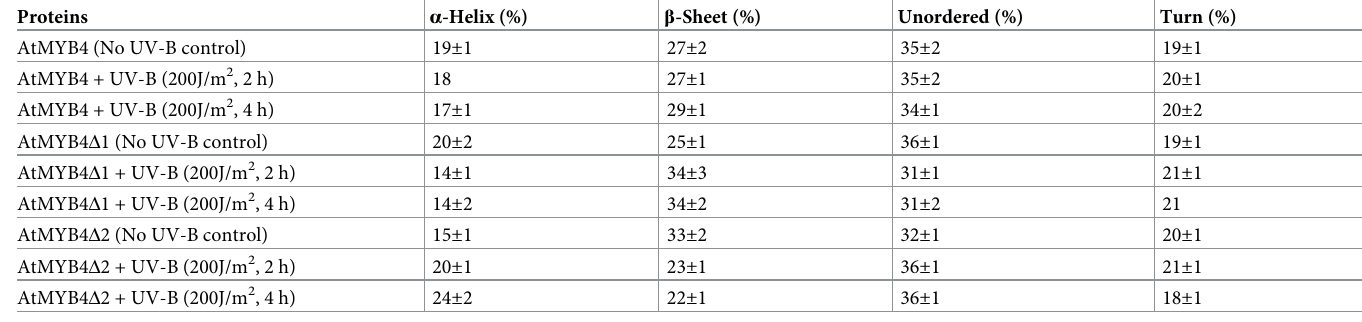
± (Errors represent SD from triplicate